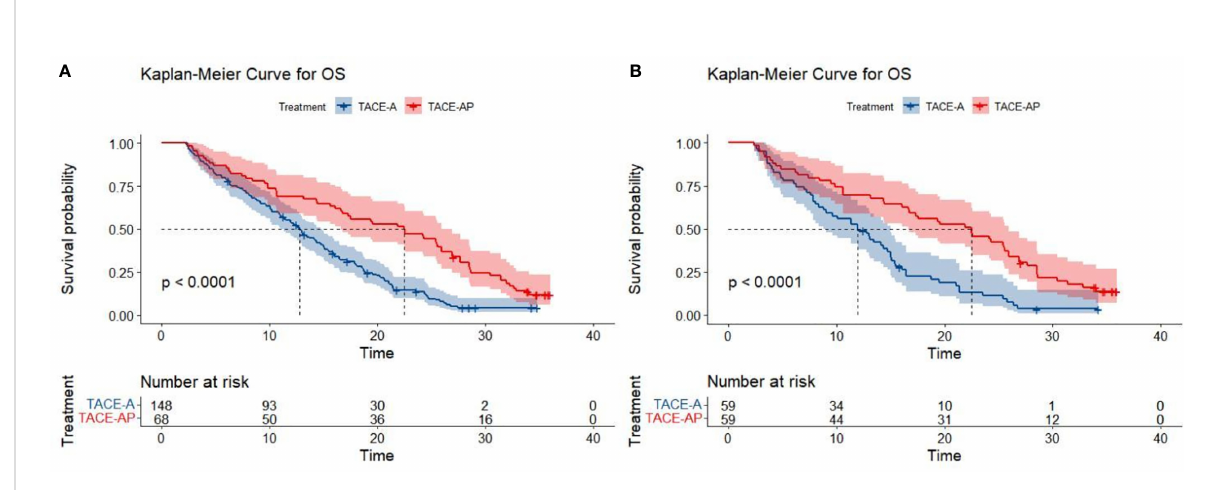
FIGURE 3 Kaplan-Meier curves for OS in patients with advanced HCC treated with TACE-A or TACE-AP before (A) and after (B)